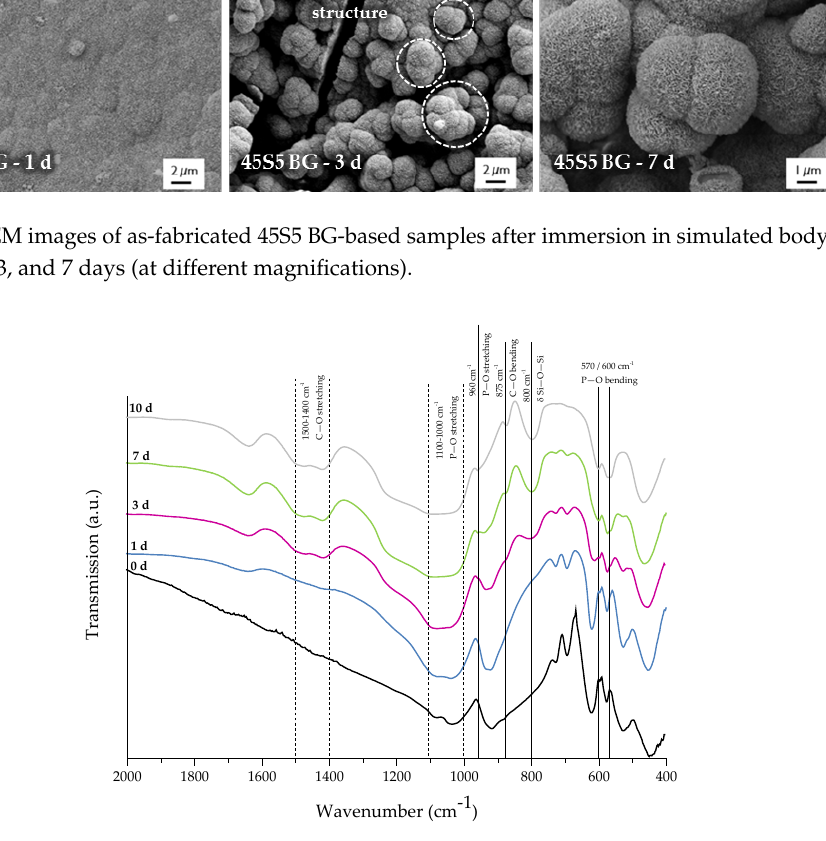
Figure 7. FTIR spectra of as-fabricated 45S5 BG-based samples after 0, 1, 3, 7, and 10 days of immersion in SBF. Relevant peaks are discussed in the